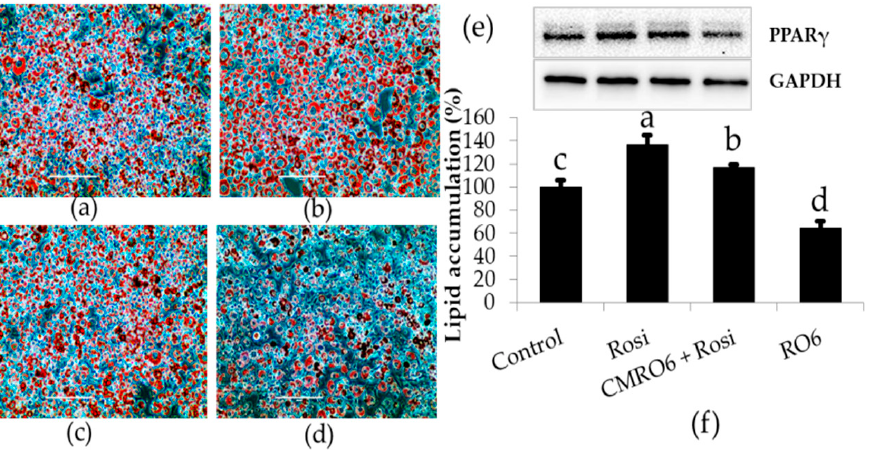
Figure 3. Comparative studies between rosiglitazone (RGZ) and CMRO6 on adipocyte differentiation. The cells were treated with either CMRO6 (100 ug/mL) or RGZ (1 µ M), or RGZ with CMRO6, when differentiation began. Adipocytes treated with RGZ differentiated faster and accumulated more fat, while cells treated with CMRO6 showed a significant reduction in fat deposition compared to controls. CMRO6 also attenuated the RGZ-induced lipid accumulation as compared to cells treated with RGZ alone. ( a ) Control cells; ( b ) RGZ-treated cells; ( c ) RGZ + CMRO6-treated cells; ( d ) CMRO6-treated cells; ( e ) PPAR- γ protein expression in the experimental cells on day 10; ( f ) fat deposition in the experimental cells on day 10, determined by Oil Red O staining method. The data are represented as the mean ± STD of six replicates (n = 6). Different letters within the figure indicate significant differences ( p <